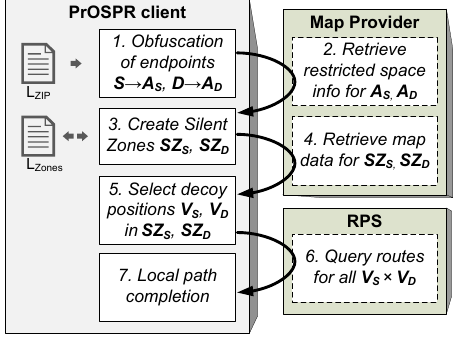
Figure 2: The basic steps of the PrOSPR